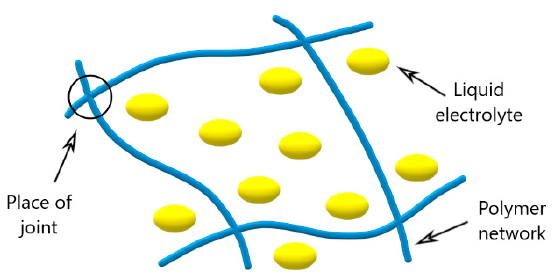
Figure 2. Scheme of cross-linkage of the polymer gel